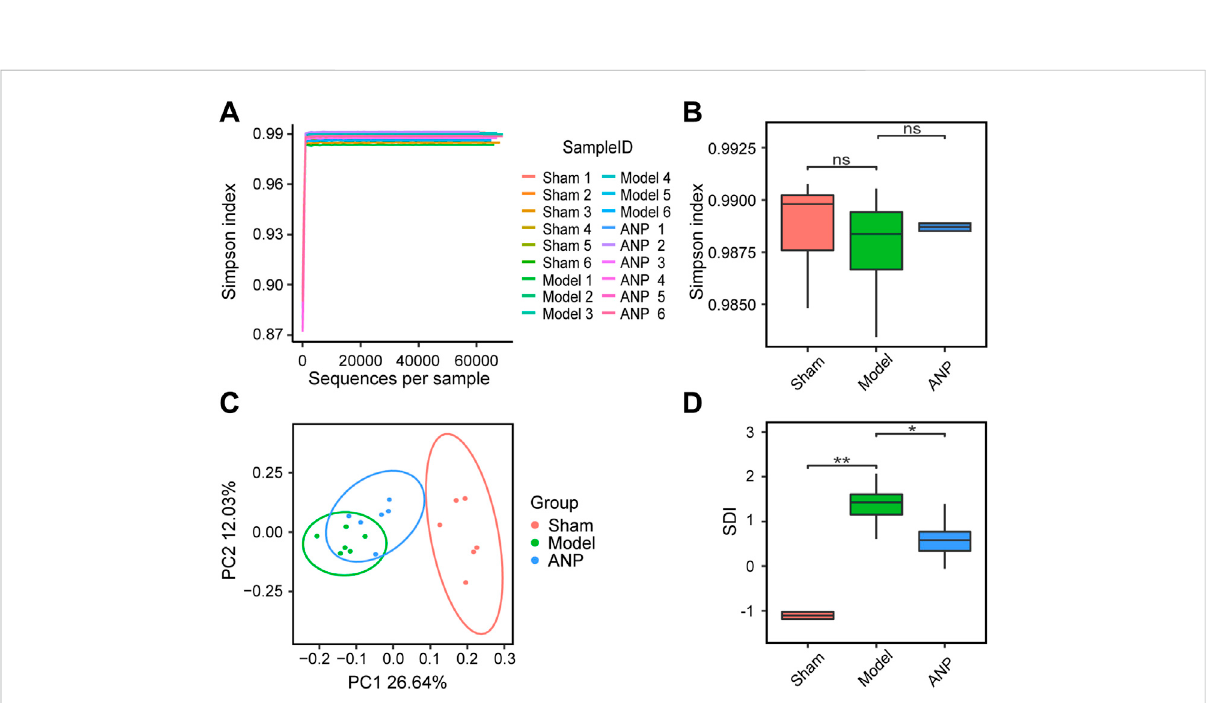
FIGURE 3 ANP reversed MCAO-induced gut microbiota dysbiosis. (A) Rarefaction curve analysis based on the Simpson index. (B) Comparison of alpha diversity based on the Simpson index. Statistical differences were examined by Wilcoxon rank-sum test. (C) The PCoA score plot using Bray-Curtis dissimilarity metric. (D) Comparison of SDI. Statistical differences were examined by Wilcoxon rank-sum test. * p < 0.05, ** p < 0.01, ns, no statistical